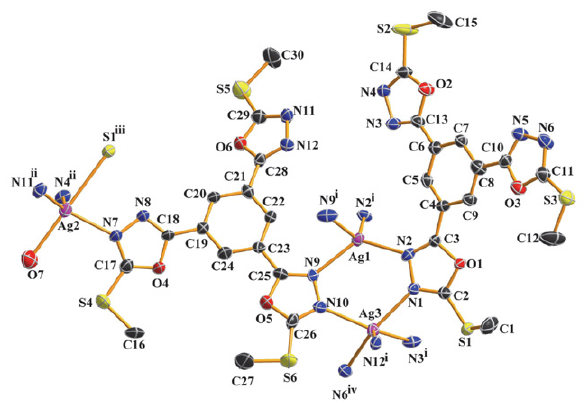
Figure 5. The coordination environment of Ag + in 2 at 50% proba- bility displacement. (Anions and solvent molecules are omitted for clarity) Symmetry codes: (i) -x+3/2, -y+3/2, z; (ii) -x+1, -y+3/2, z+1/2; (iii) x-1/2, y, z+1/2; (iv) -x+7/4, y-1/4, z+1/4.